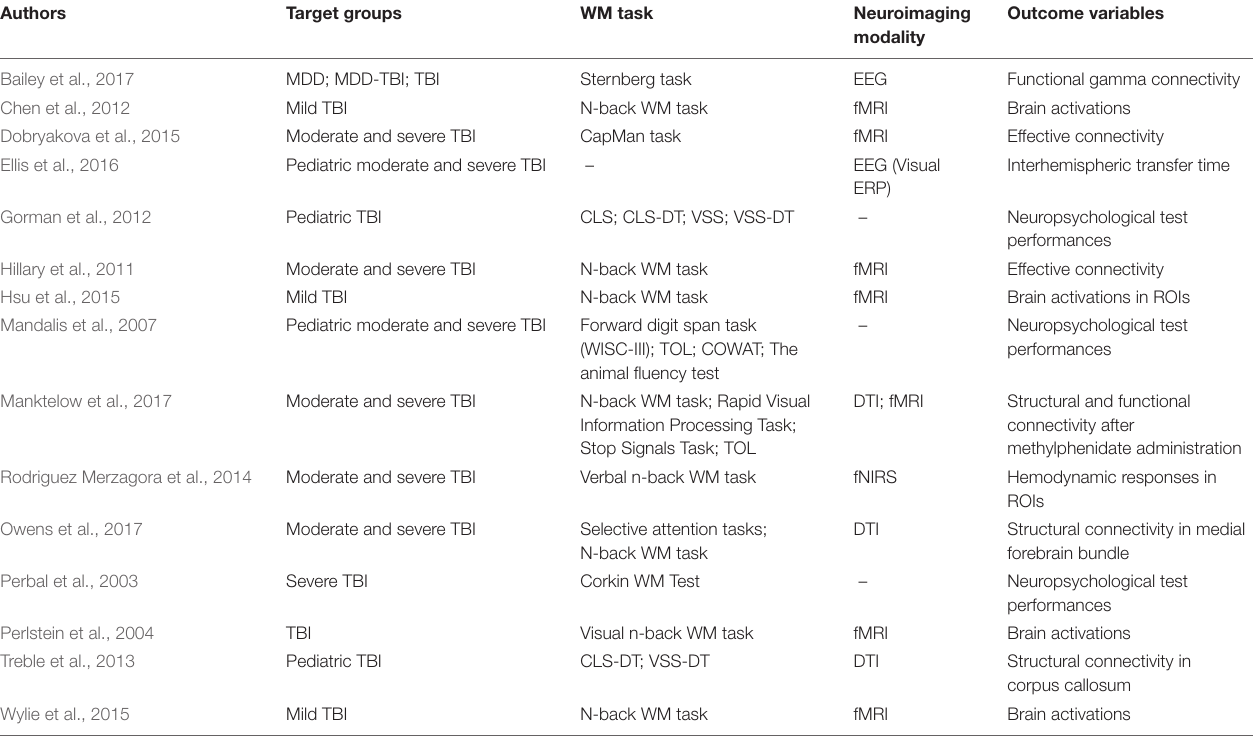
TABLE 4 | Working memory (WM) studies in the TBI